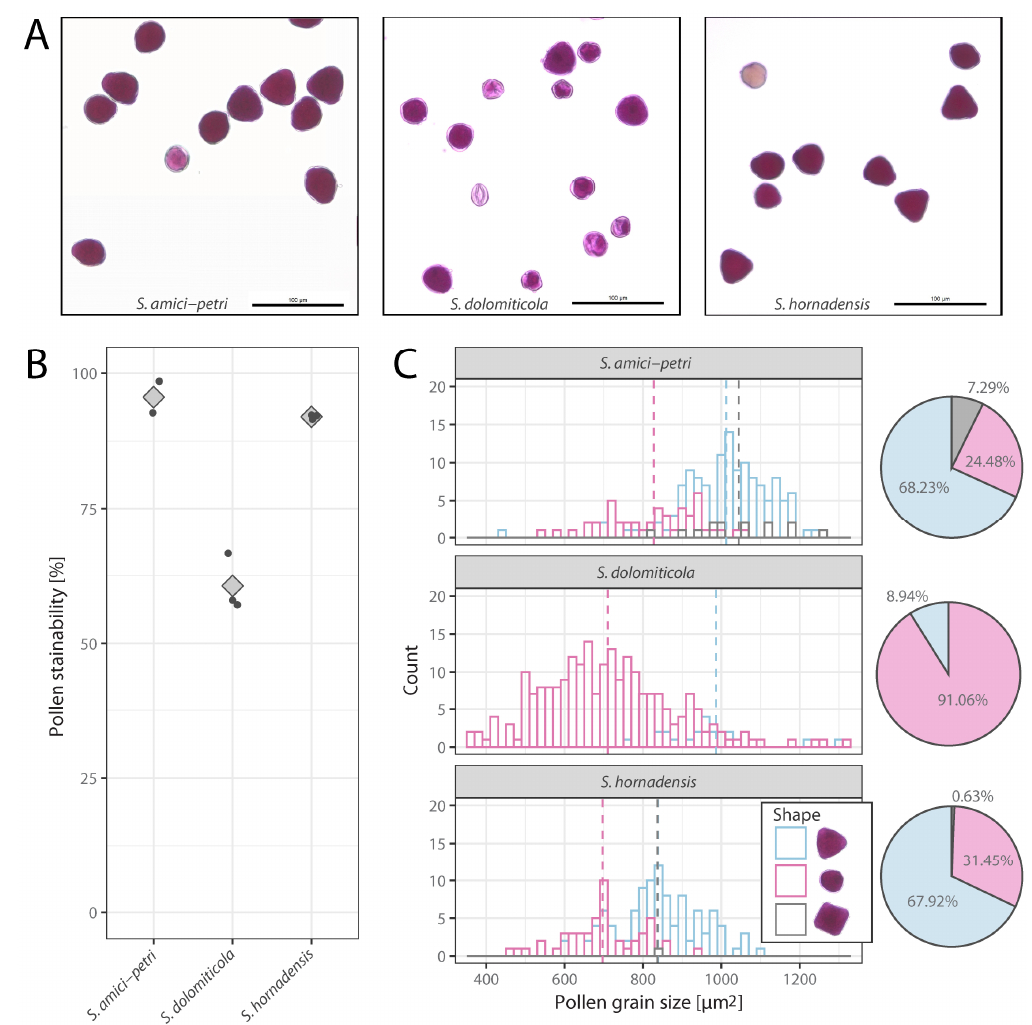
Figure 2. Pollen stainability and pollen size in polyploids Sorbus amici-petri , S. dolomiticola , and S. hornadensis. ( A ) Representative microscopic views of stained pollen grains of three species. ( B ) Variation in pollen stainability among species. ( C ) Pollen grain size and proportion of pollen shape types. In B, dots and diamonds represent pollen stainability per sample and their averages, respectively. Dashed lines are mean values in ( C ).